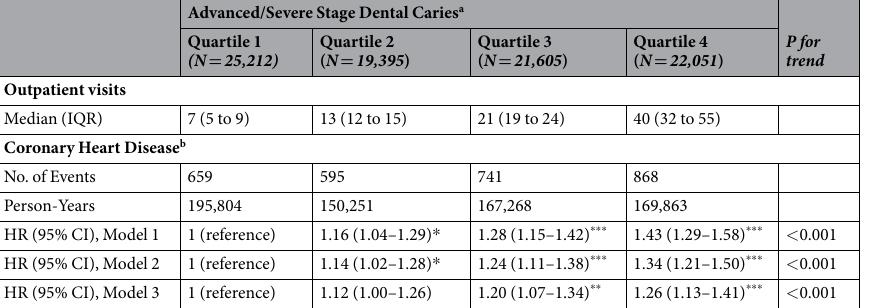
Table 3. Dose-response relationship between advanced/severe stage dental caries and coronary heart disease in the National Health Insurance Service-Health Screening Cohort (NHIS-HEALS). a Includes ICD-10 codes for irreversible pulpitis (K04.0), necrosis of pulp (K04.1), and periapical abscess with sinus (K04.6) with at least 2 outpatient visits. b Includes ICD-10 codes for coronary heart disease (I20–I25) NOTE: Models represent multivariable Cox regression models. Model 1 adjusted for age, sex, insurance premium, residential area. Model 2 adjusted for variables included in Model 1 and year of diagnosis, physical activity, alcohol consumption, cigarette smoking, total cholesterol level, fasting serum glucose level, systolic blood pressure, body mass index. Model 3 adjusted for variable included in Model 2 and family history of heart disease, and Charlson Comorbidity Index. Abbreviation: IQR, interquartile range; HR, hazard ratio; CI, confidence